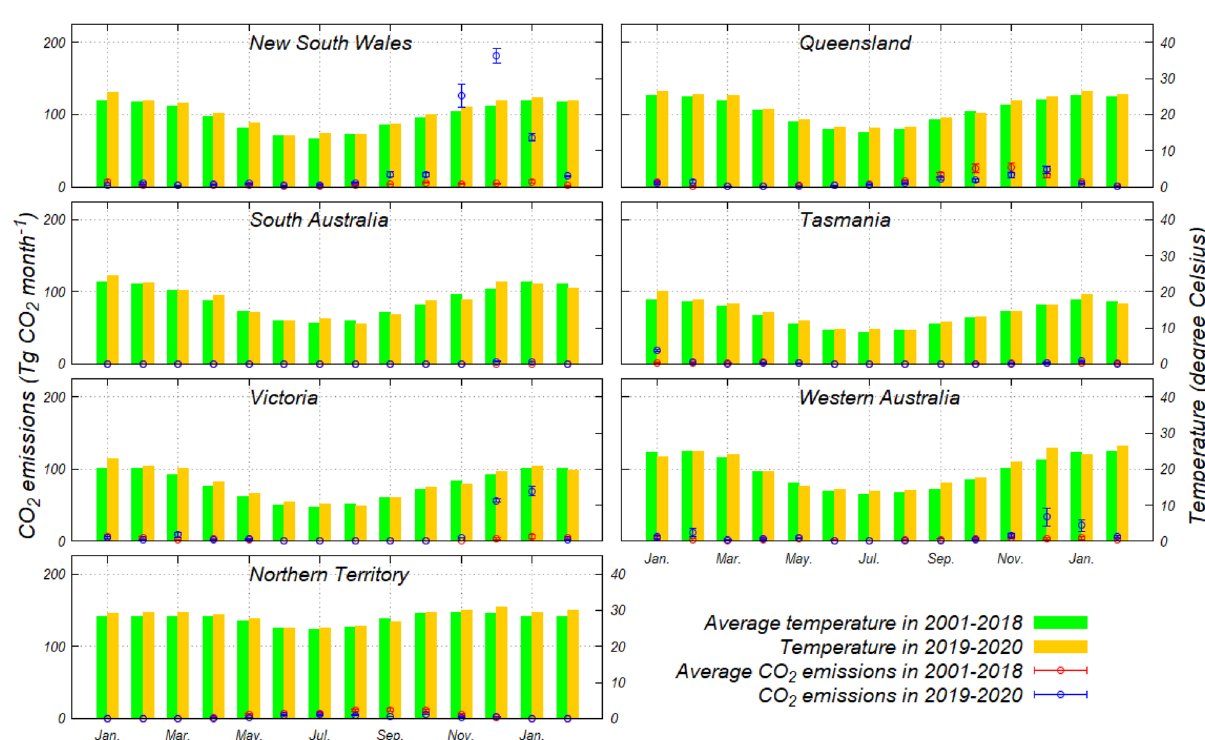
Figure 5. Comparison between monthly CO 2 emissions (Tg CO 2 month −1 ) and monthly mean temperatures (°C) in six states and one territory for 2001–2018 and for 2019–2020, respectively. Note that the average and one standard deviation of the CO 2 emissions for 2001–2018 were measured for each month of the year, and those of 2019–2020 indicate the eight results from a combination of input